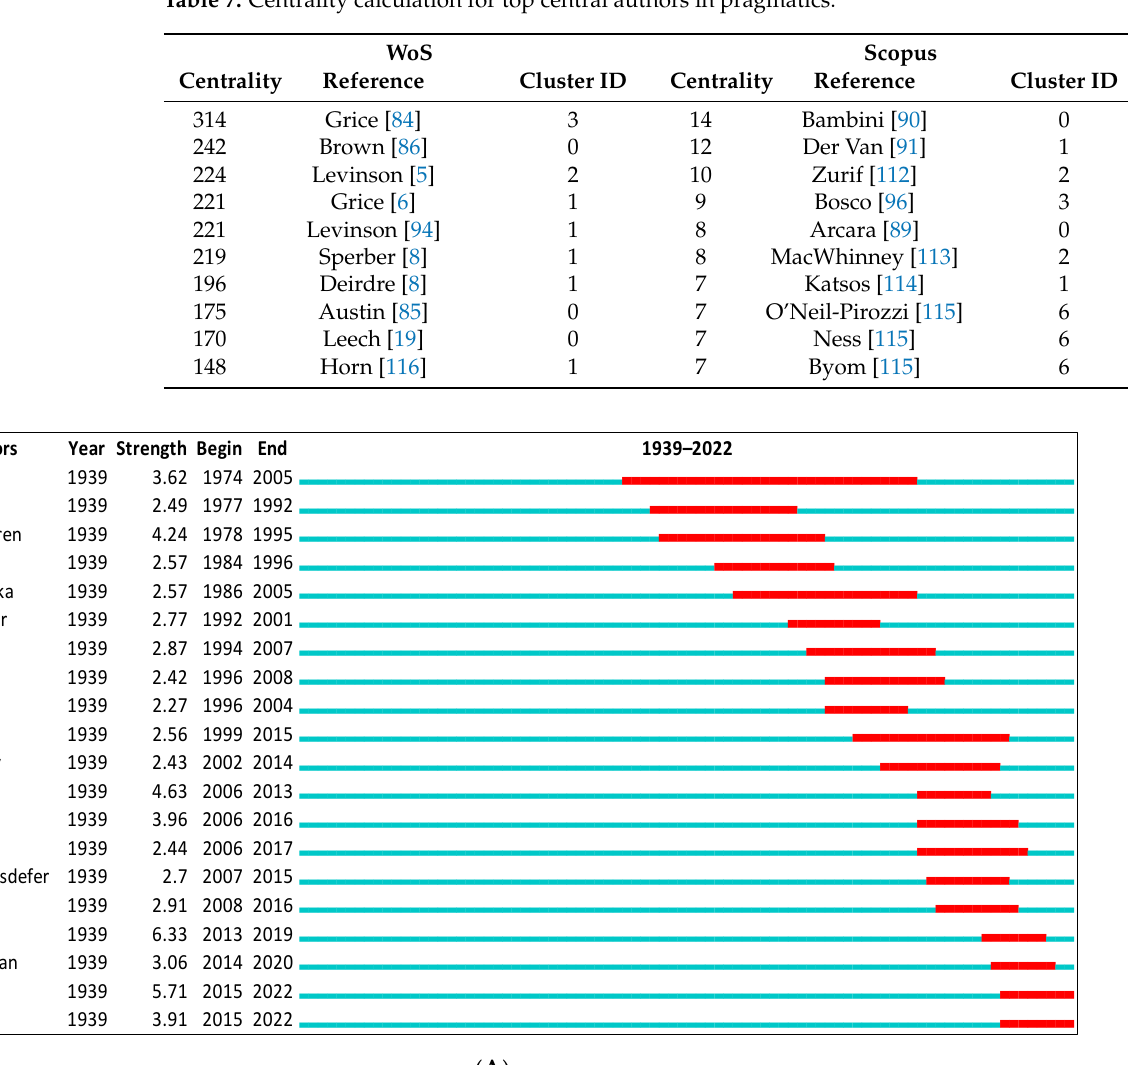
Table 5. Citation counts for pragmatics